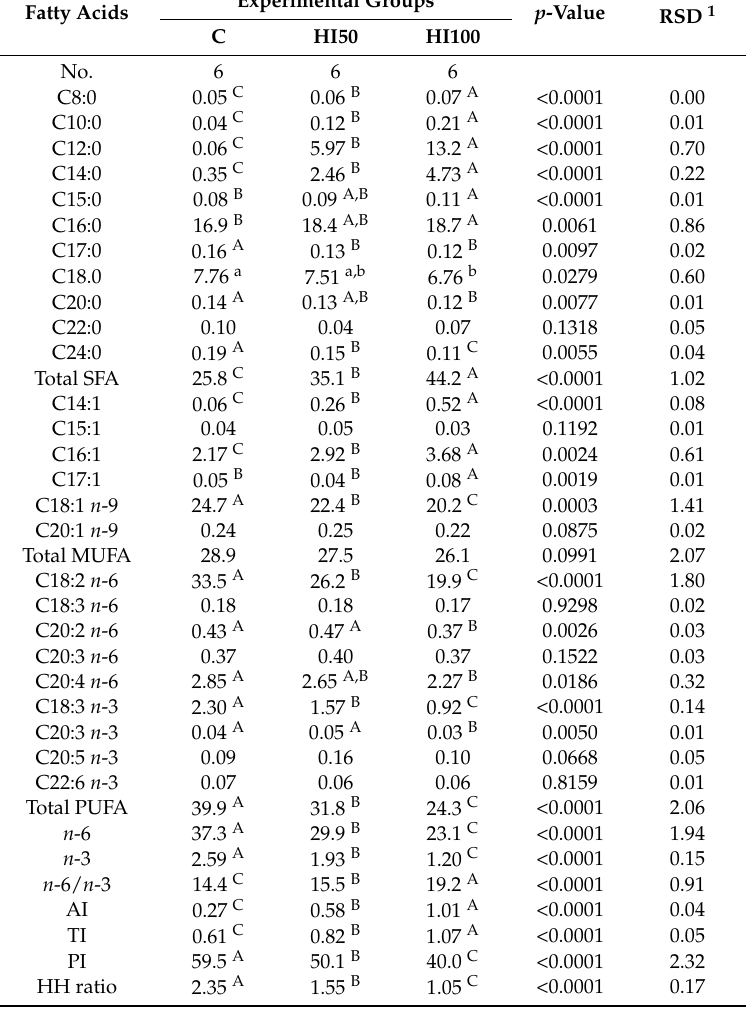
Table 6. Fatty acids profile (% of total FAME) of the leg meat of chickens fed with 0% (C), 50% (HI50) and 100% (HI100) substitution of soybean oil with Hermetia illucens (HI) larvae fat in their finisher diets. Experimental Groups p -Value RSD 1 Fatty Acids C